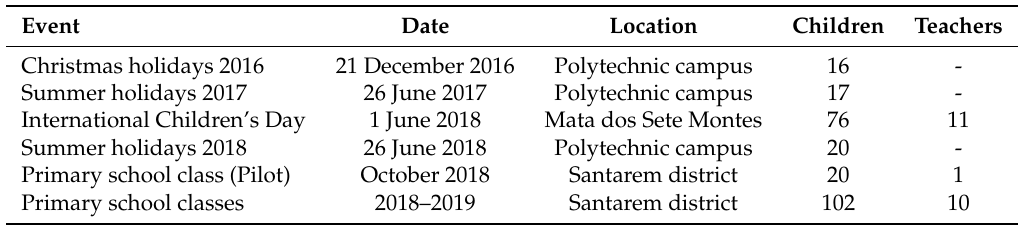
Table 4. Implementation tests of the